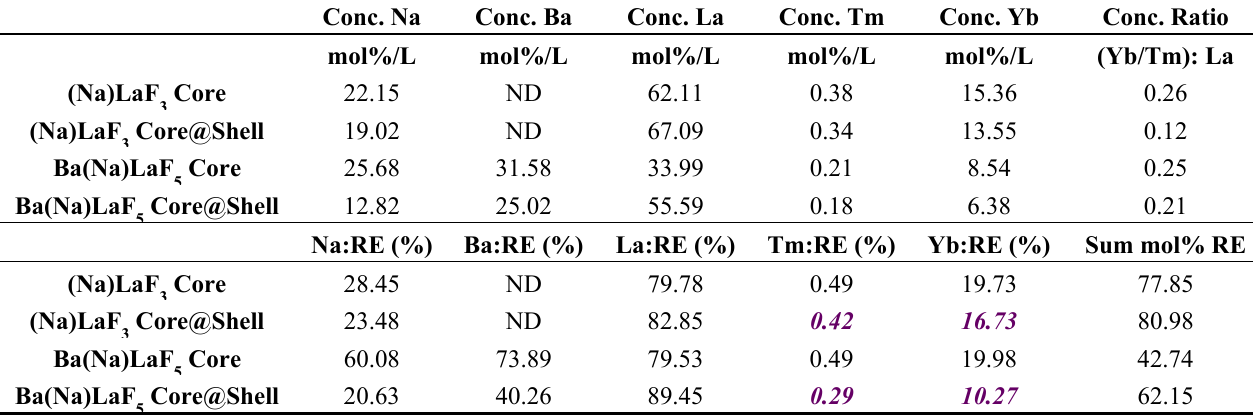
, and Ba(Na)LaF 3